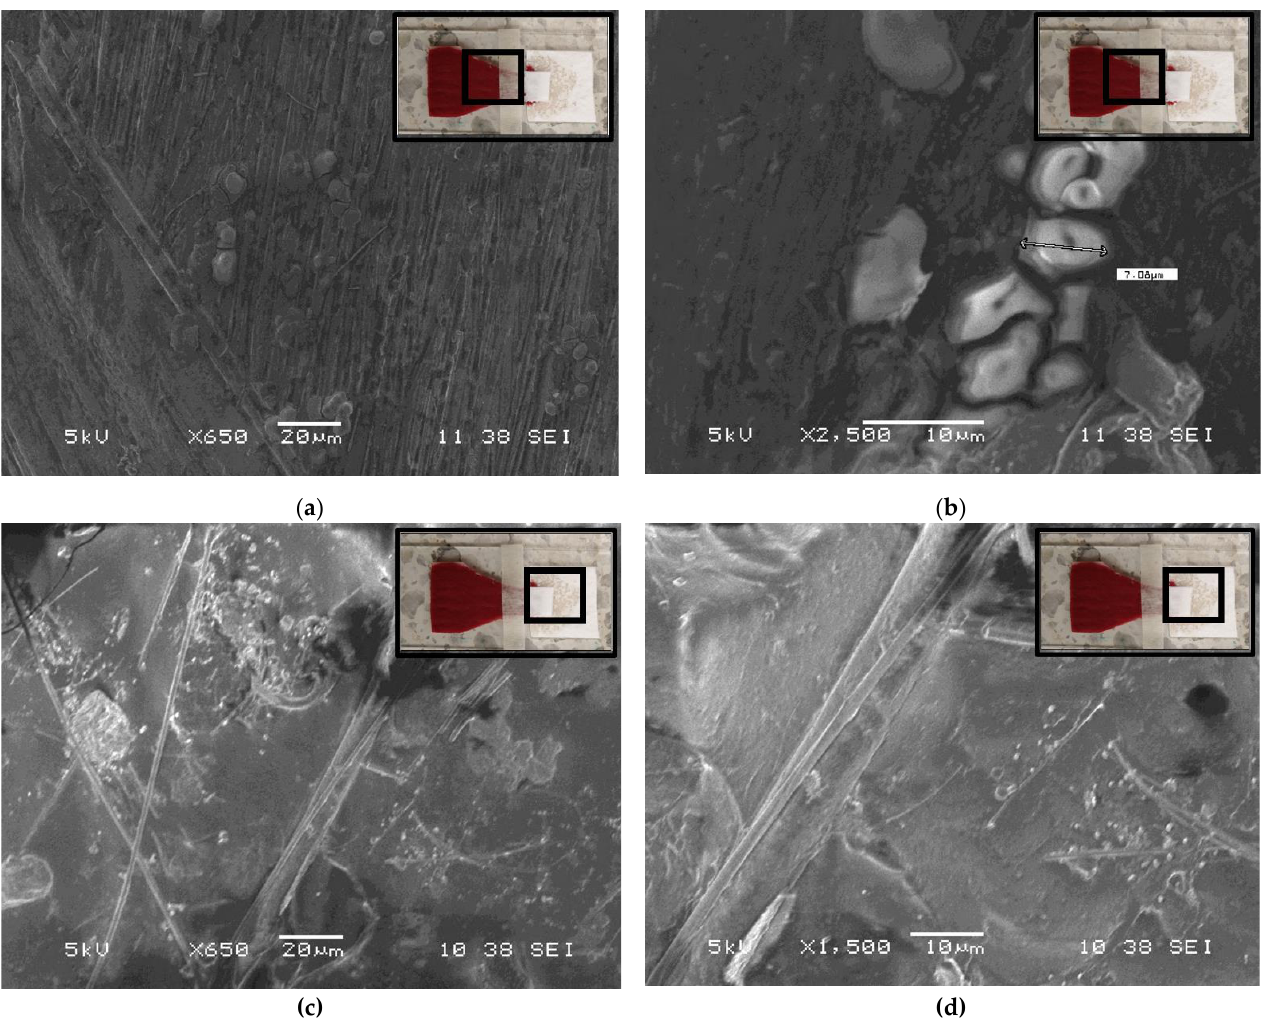
Figure 4. Visual comparison of SEM images of the remaining formed elements of a whole blood sample on the surface of the VF2 collection pad at ( a ) 650× and ( b ) 2500×, and on the MF1 detection pad at ( c ) 650× and ( d ) 1500×. RBCs bound to the VF2 paper fibers are shown in ( b ), and the diameter of one RBC is displayed.